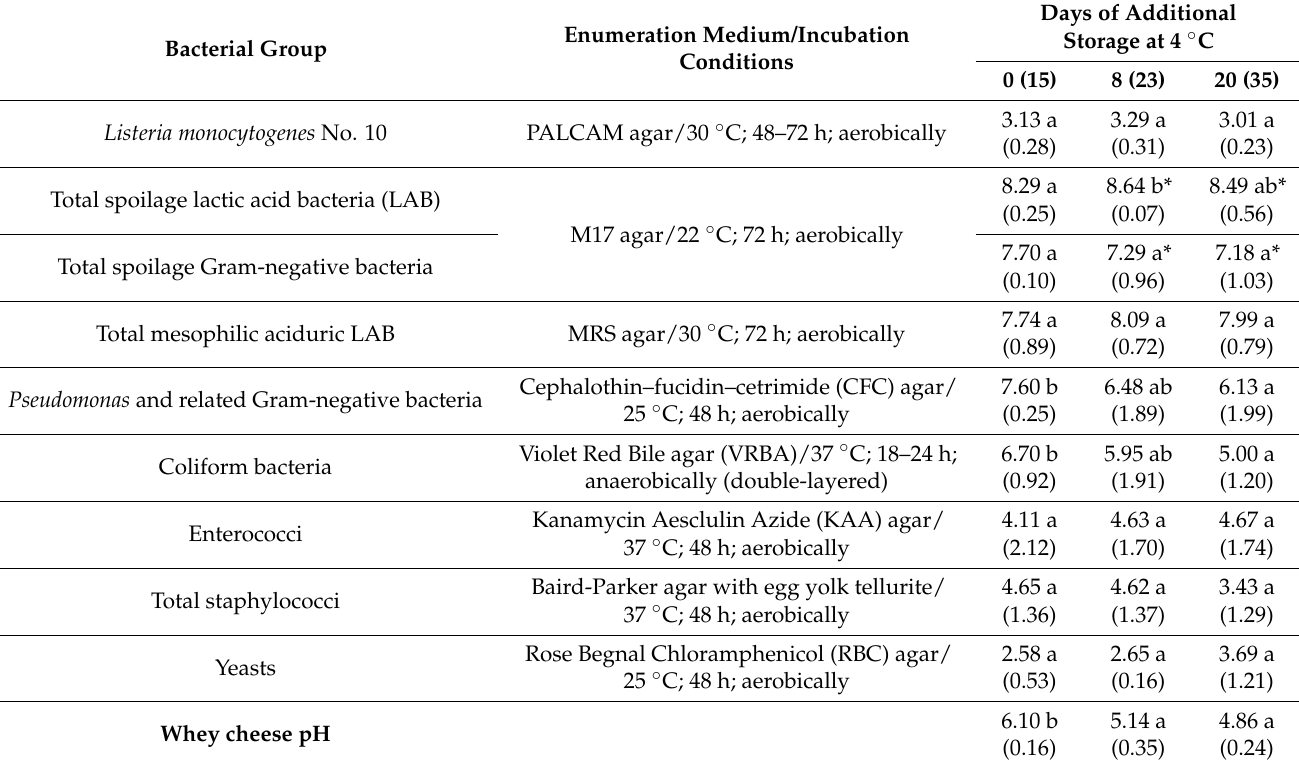
Table 3. Behavior of inoculated L. monocytogenes (log 10 CFU/g) in association with the growth of the spoilage microbiota (log 10 CFU/g) and the pH changes during additional refrigerated (4 ◦ C)